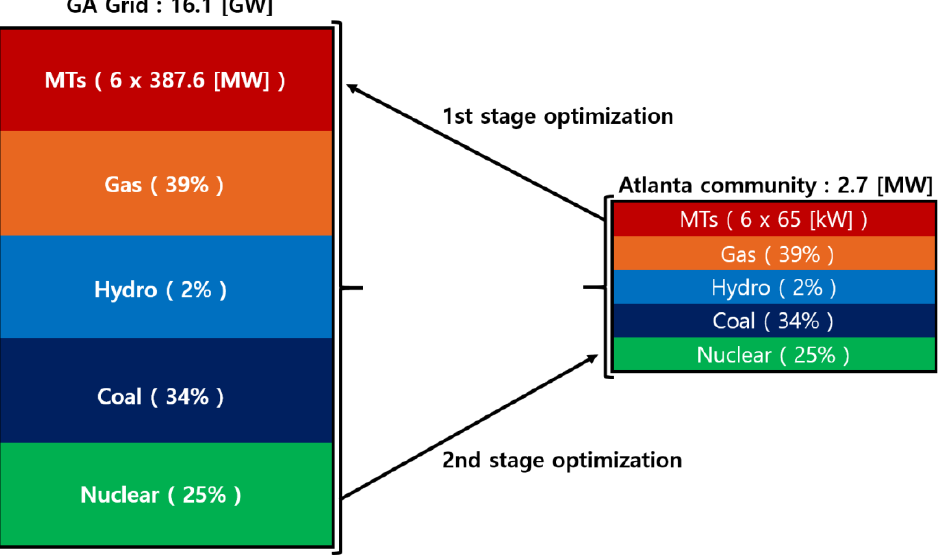
Figure 8. Proposed two-stage optimization process. Figure 8. Transformation of generation proportions in two-stage